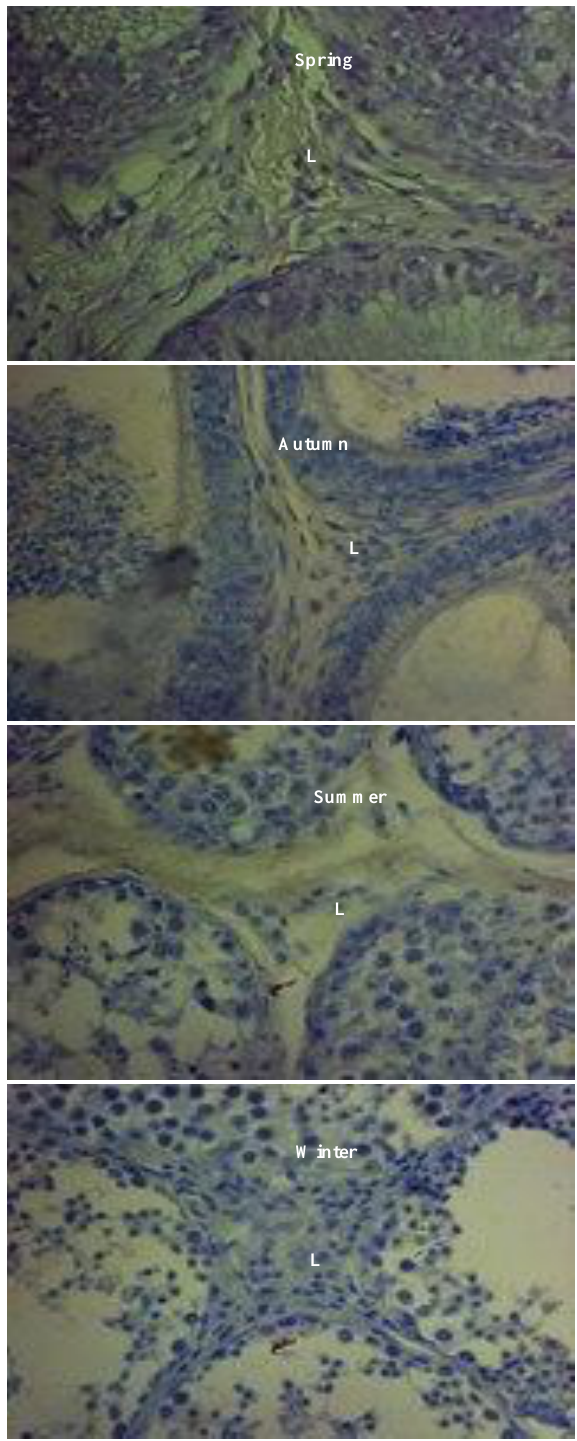
Figure, 5: Immunolocalization of Leydig cells (L) during different seasons. ×400.